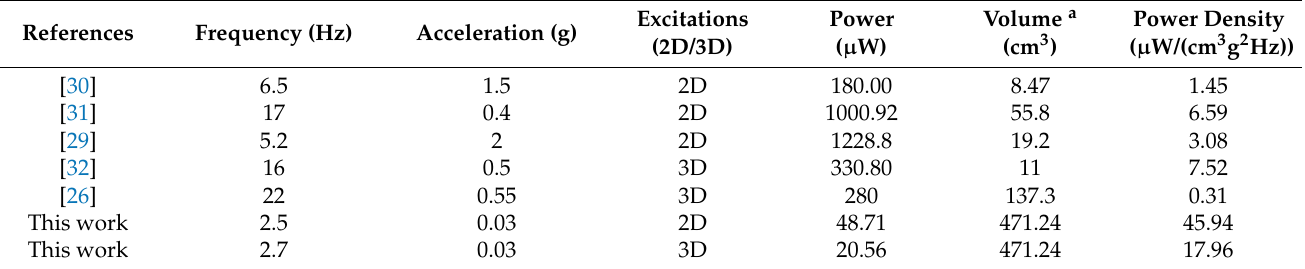
Table 2. Performance comparison of the proposed PVEHs with the existing PVEHs.